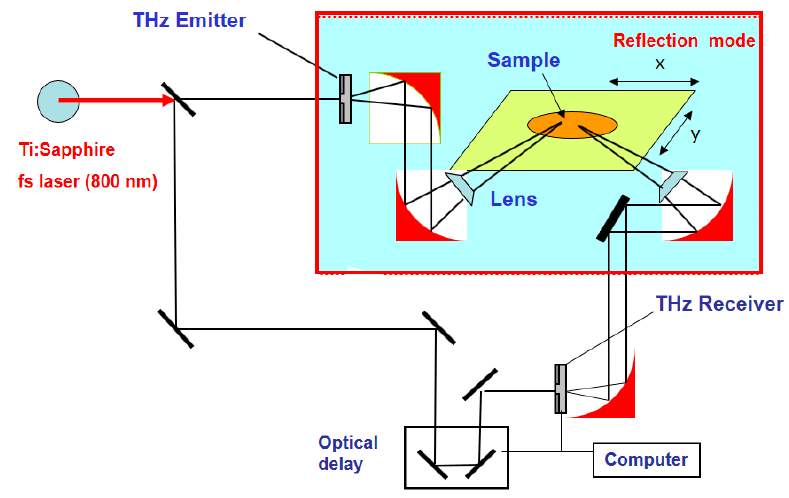
Figure 2. A simplified block scheme of the THz measurement method.